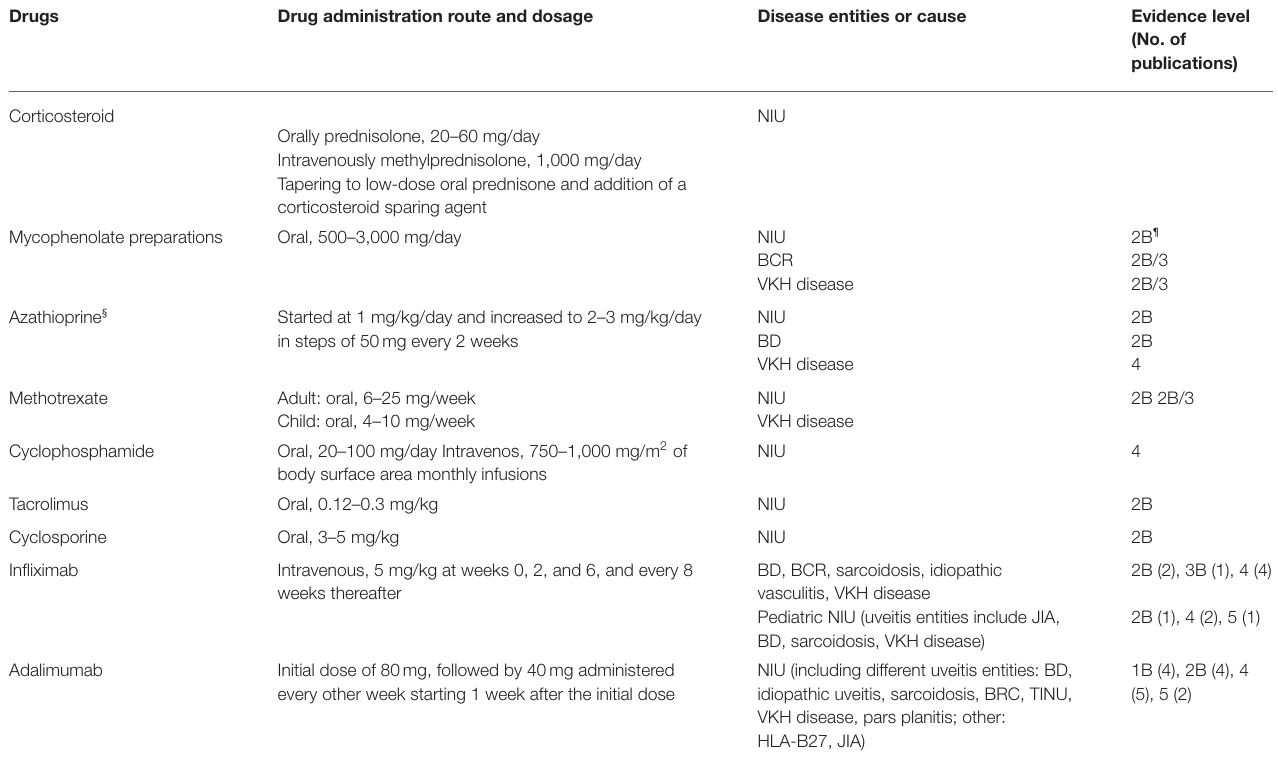
Drugs Drug administration route and